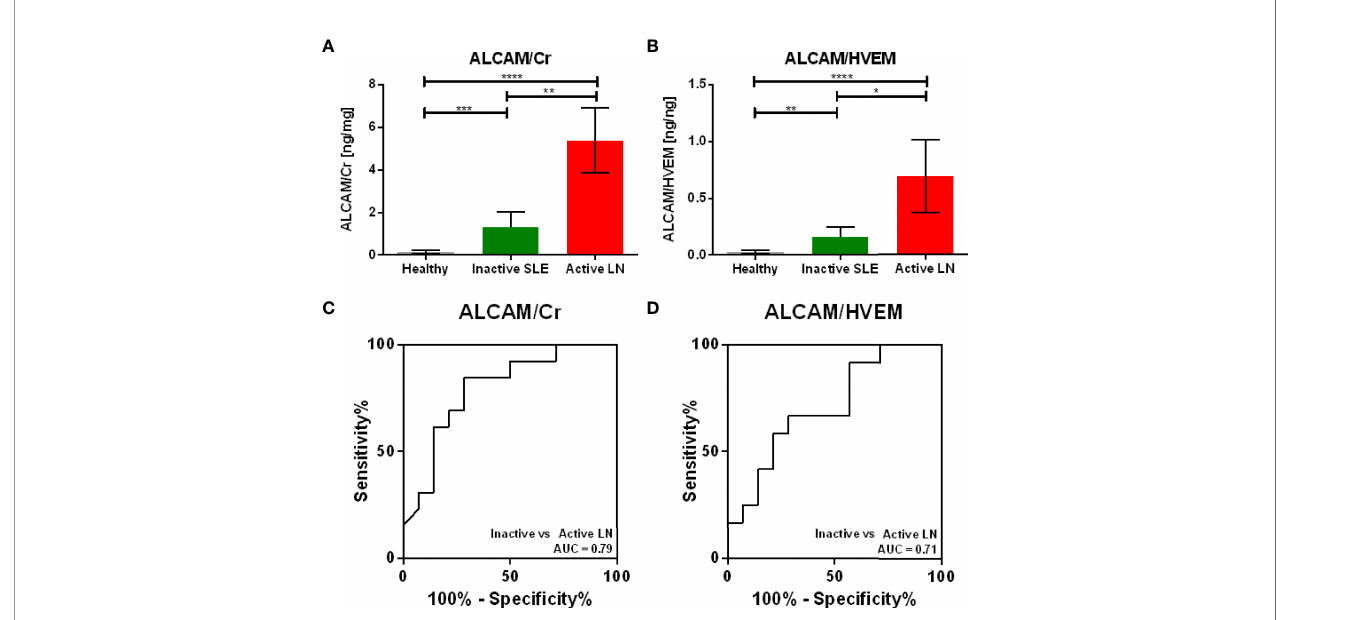
FIGURE 6 | Normalizing Urine ALCAM using Urine HVEM versus Urine Creatinine. As urine HVEM emerged as the most promising marker for urine biomarker normalization, the diagnostic utility of HVEM normalization was compared to the gold standard, creatinine normalization. Normalization of urine ALCAM, a proposed biomarker for diagnosing lupus nephritis, using urinary creatinine (A) and urinary HVEM (B) shows comparable active versus inactive lupus nephritis ALCAM fold changes of 4.06 and 4.41, respectively. The diagnostic ability of ALCAM normalized with creatinine (C) and ALCAM normalized with HVEM (D) shows comparable ROC AUC values of 0.79 and 0.71, respectively. Bars show mean ± standard error of the mean. One sample was removed from the plots, as the HVEM concentration was too low to be detected by ELISA. *, **, *** and **** represent p < 0.05, p < 0.01, p < 0.001 and p < 0.0001,